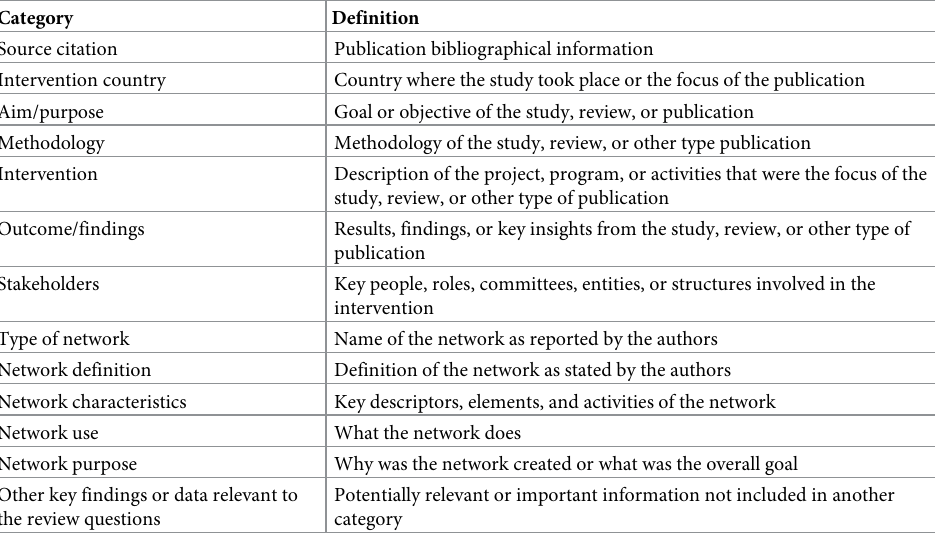
Table 1. Data charting categories and definitions.